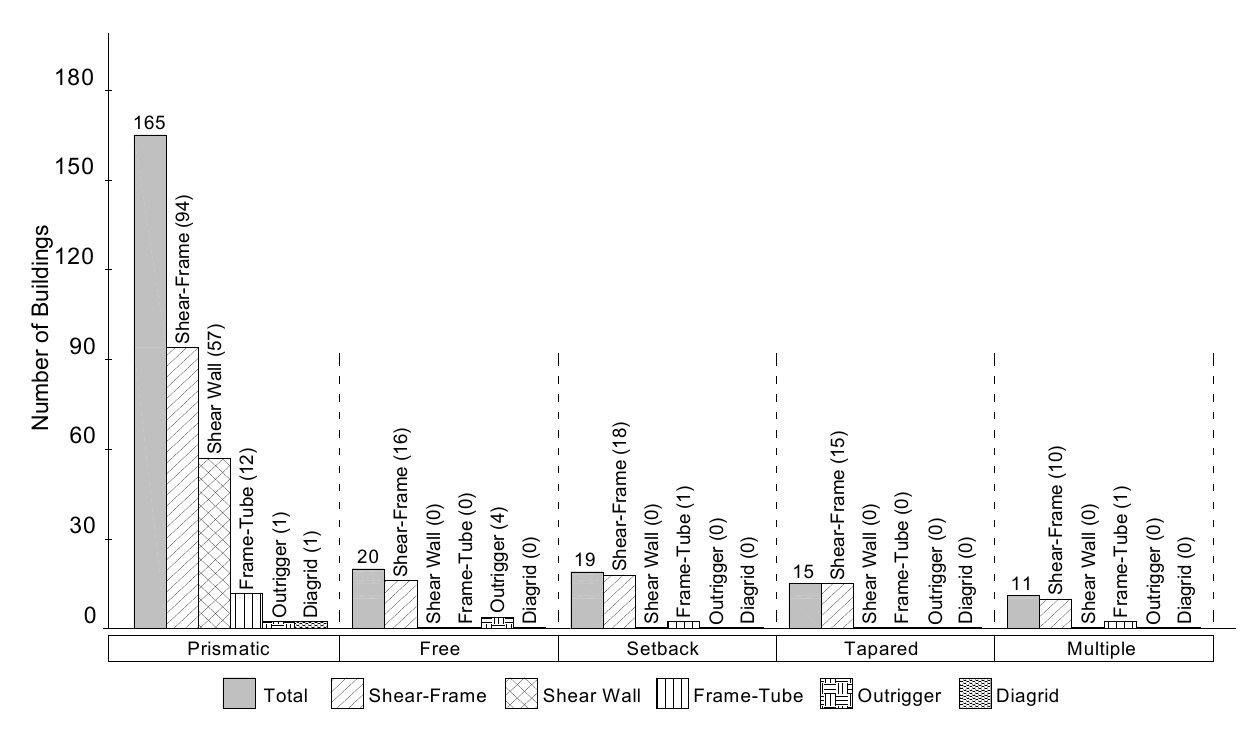
Figure 12. Relation between building form and structural system.